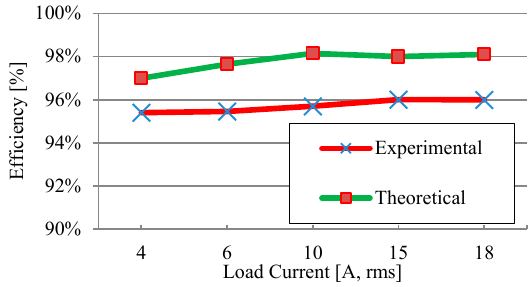
Figure 12. Experimental and theoretical efficiency analysis.